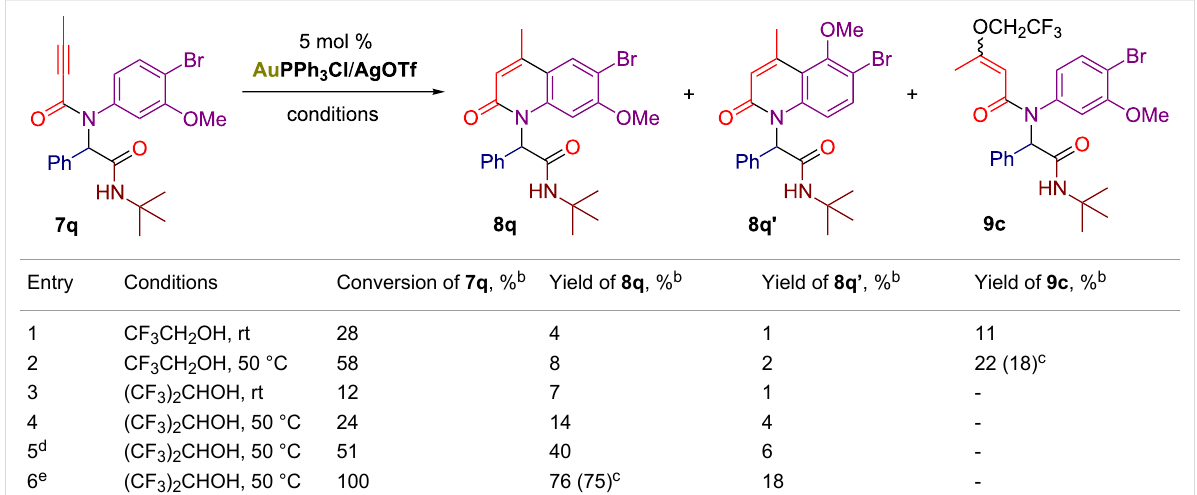
Table 3: Screening the conditions for the gold-catalyzed intramolecular hydroarylation of the Ugi adduct 7q . a